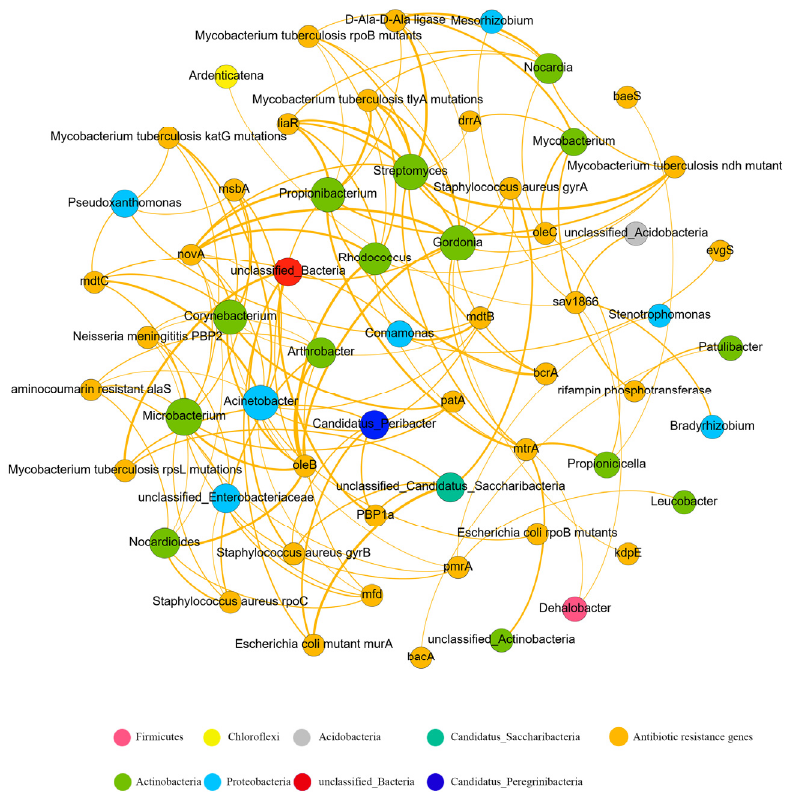
Figure 6. The co-occurrence network of bacterial genera with the ARG subtypes of different categories. The nodes were colored according to phylum. The size of each node is proportional to the number of connections.